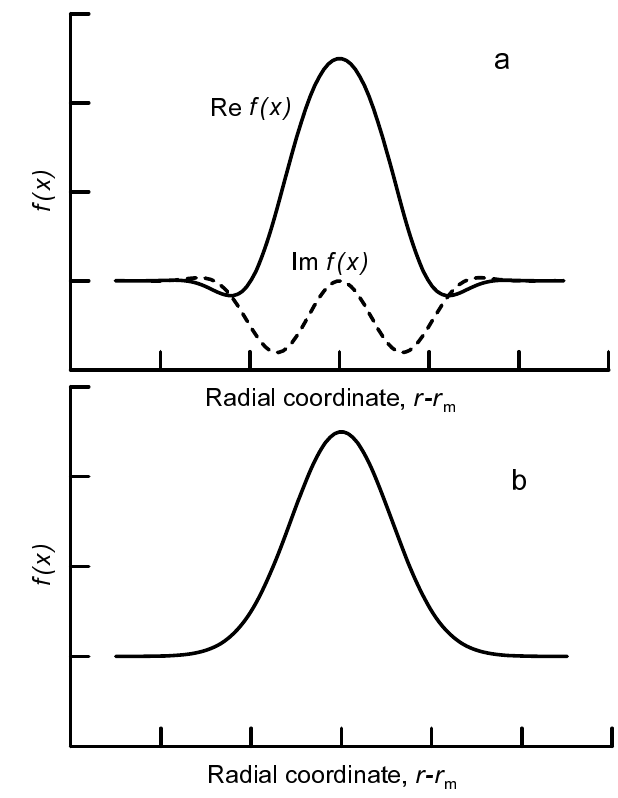
Fig. 1. The mode structure across magnetic shells: (a) when | γ |(cid:28)| ω ∗ | , (b) when | γ |(cid:29)| ω ∗ | .